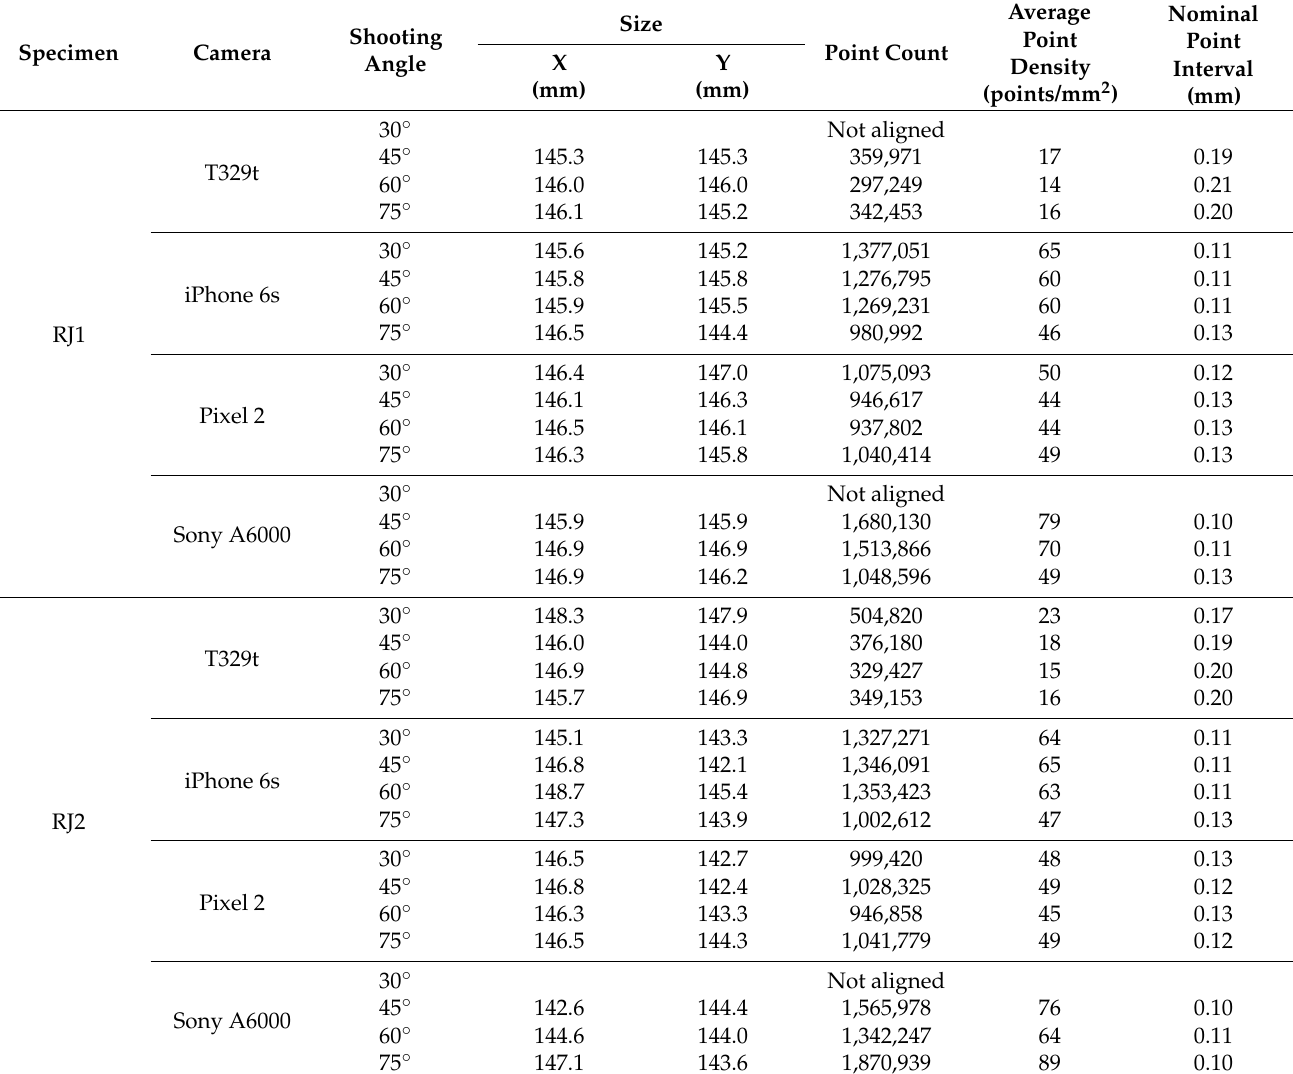
Table 4. The average point density and nominal point interval of the structure from motion (SfM) models generated with the different shooting angles under the FSC